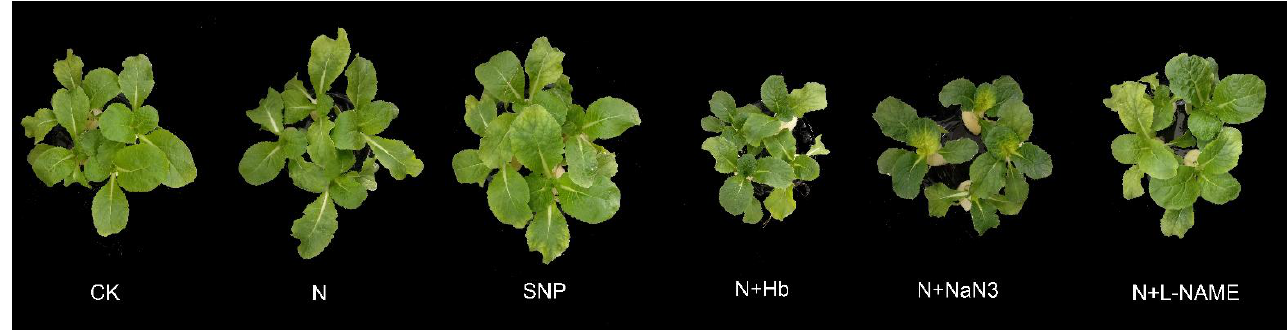
* Values were presented with means ± SE ( n = 3 with 10 seedlings per replication), and different letters in the same column indicated significant differences ( p ≤ 0.05) among treatments. Abbreviations: CK , ammonium/nitrate = 0/100, and the total nitrogen concentration was 5